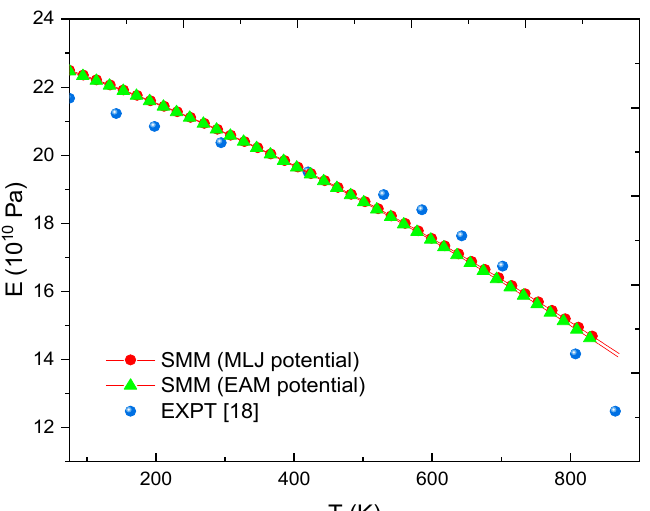
Figure 3. E(T) at P = 0 determined using the SMM with MLJ potential, SMM with EAM potential [47] and from EXPT [18] with FeC 0.2% alloy.